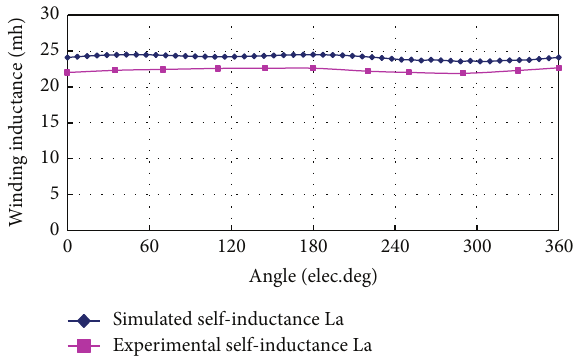
Figure 11: Comparison of self-inductances between FEA and experimental